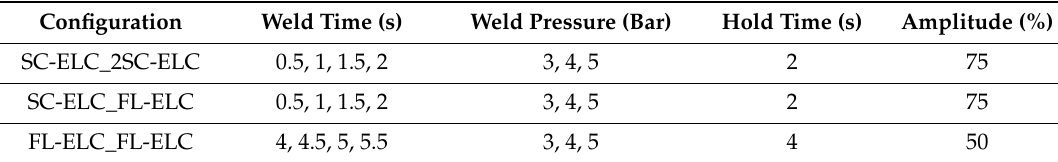
Table 4. Design of experiment for the current